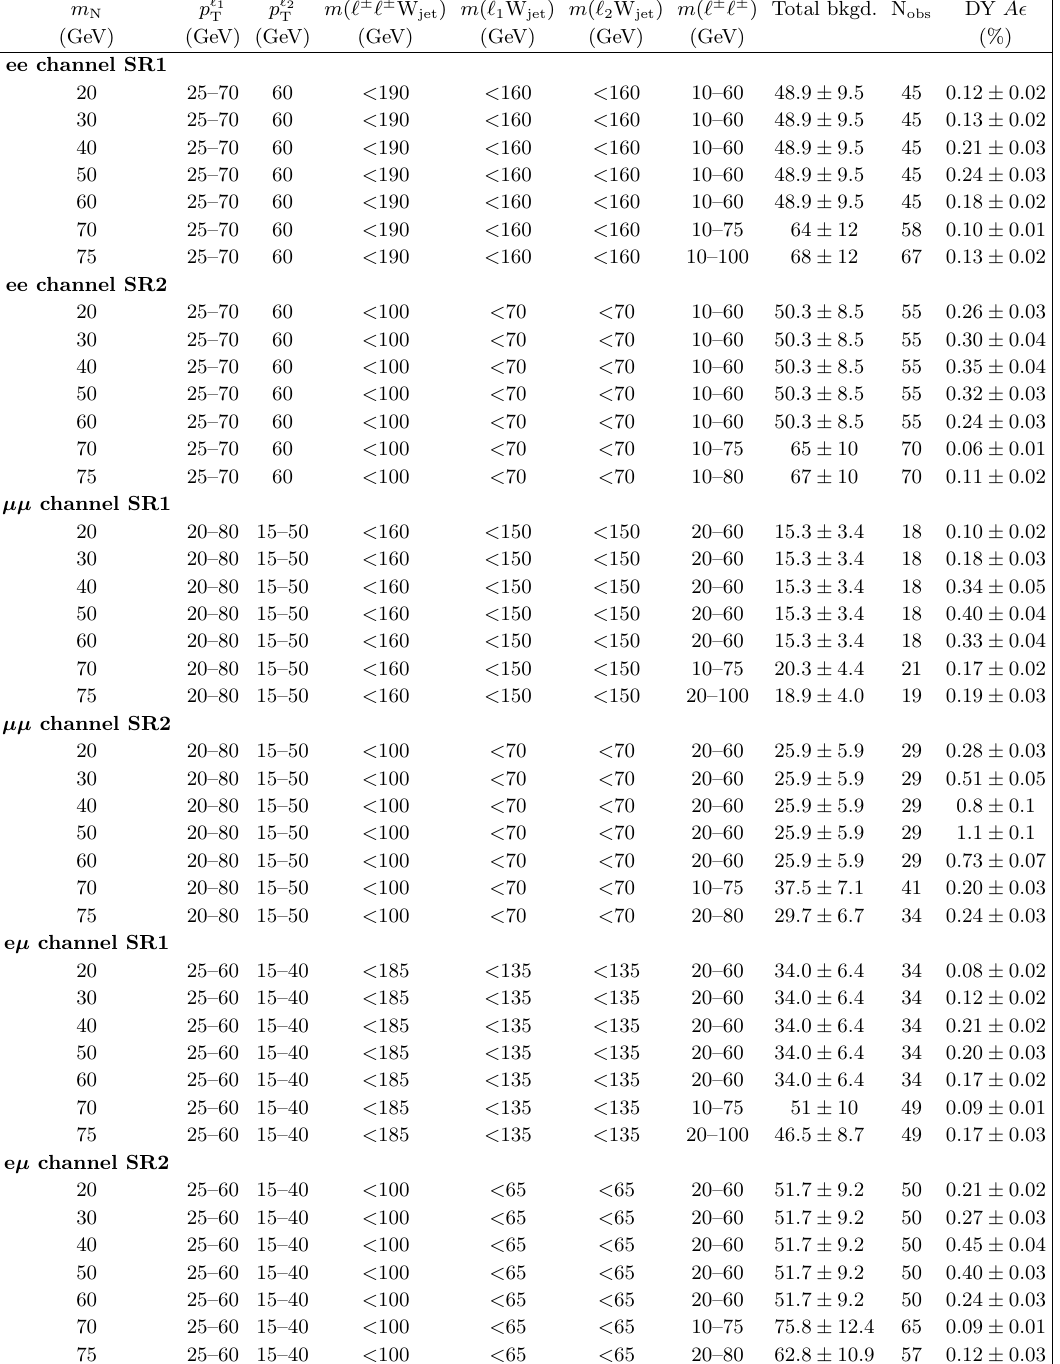
Table 7 . Selection requirements on discriminating variables determined by the optimization for each Majorana neutrino mass point in the low-mass signal regions. Columns 8 and 9 show the total background yields (Total bkgd.) and the number of observed data (N obs ), respectively. The last column shows the overall signal acceptances for the DY channel. The quoted uncertainties include both the statistical and systematic contributions.